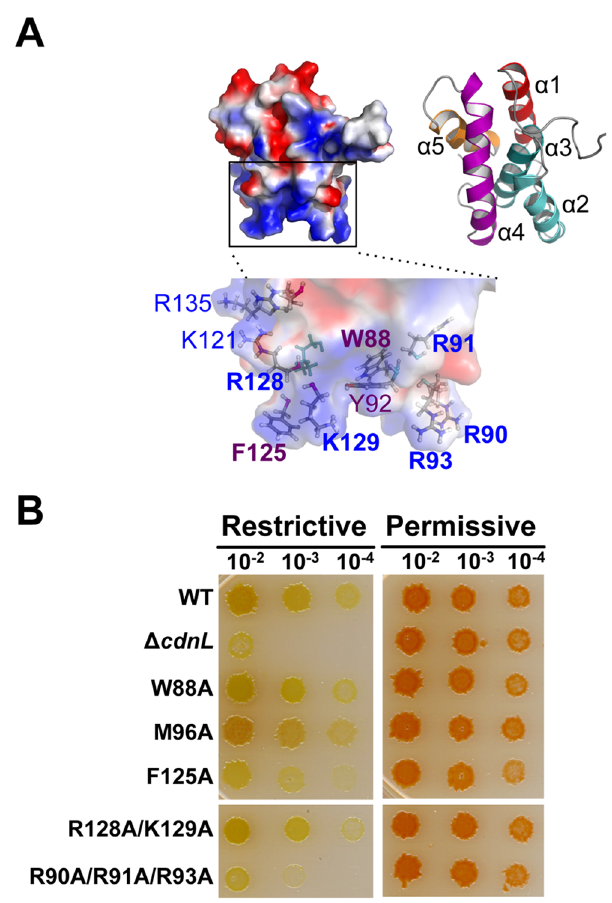
Figure 6. Consequences invivo of mutating the CdnLCt solvent-exposed basic-hydrophobic patch. ( A ) CdnLCt electro- static surface (left) and ribbon representations (right; each helix is labeled and colored differently) generated using PyMOL. The zoom shows sidechains (as sticks) of the labeled nonpolar and basic residues composing the solvent-exposed basic-hydrophobic patch. ( B ) Comple- mentation analyses in M. xanthus of the CdnL W88A, M96A, F125A, R128A/K129A, and R90A/R91A/R93A mutants versus wild-type CdnL (WT) and D cdnL , as in Figure 5B. doi:10.1371/journal.pone.0108946.g006 (compare Figure 7C with Figure S3C in File S1). This effect was not observed with isolated CdnL domains, or CarDNt, indicating that only full-length CdnL is capable of stabilizing RP o formation (Figure 7C). This was further tested with the two loss-of-function CdnL mutants that phenocopy a D cdnL strain (F36A that does not interact with RNAP, and R90A/R91A/R93A that does interact), and two other CdnL mutants that interact with RNAP and cause mild or no apparent effects in vivo (F125A and W88A, respectively). Differences among CdnL and its mutants in stabilizing RP o were subtle at P B , but more pronounced at P 4 rrnD (Figure 7D, E): the stable RP o complex at P 4 rrnD continued to be detected with the W88A or F125A mutants, was faint with F36A, and disappeared with R90A/R91A/R93A. RP o formation and stability is a crucial rate-limiting step in transcription especially at rRNA promoters [2], and the effects due to the presence of CdnL or each of its above mutants in heparin-challenged, single round transcription run-off assays from P 4 rrnD in vitro (Figure 7F) correlated well with the EMSA results on stable RP o formation. That disrupting the interaction with RNAP precludes CdnL from